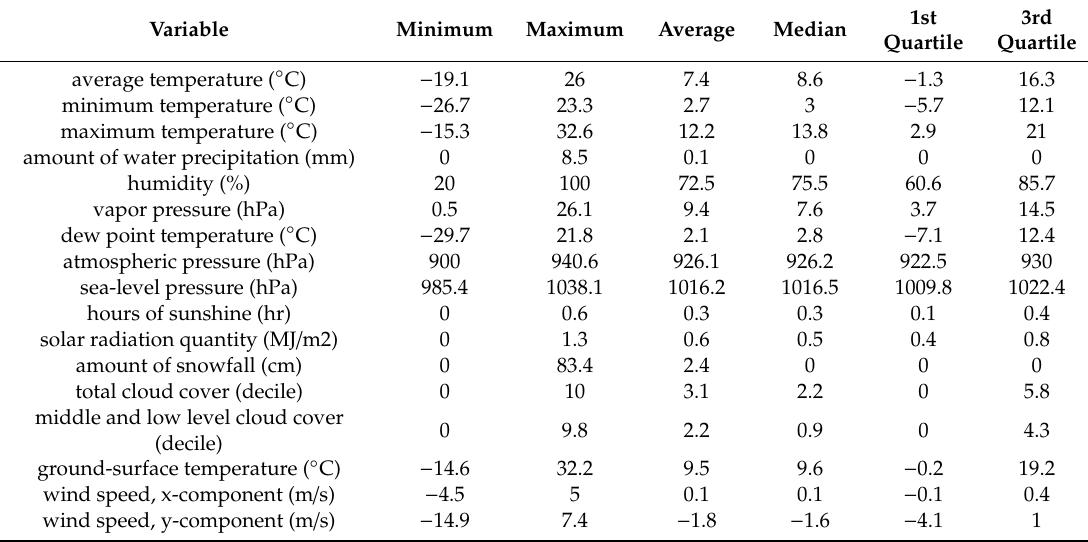
Table 12. Basic statistics for daily data in mountainous area